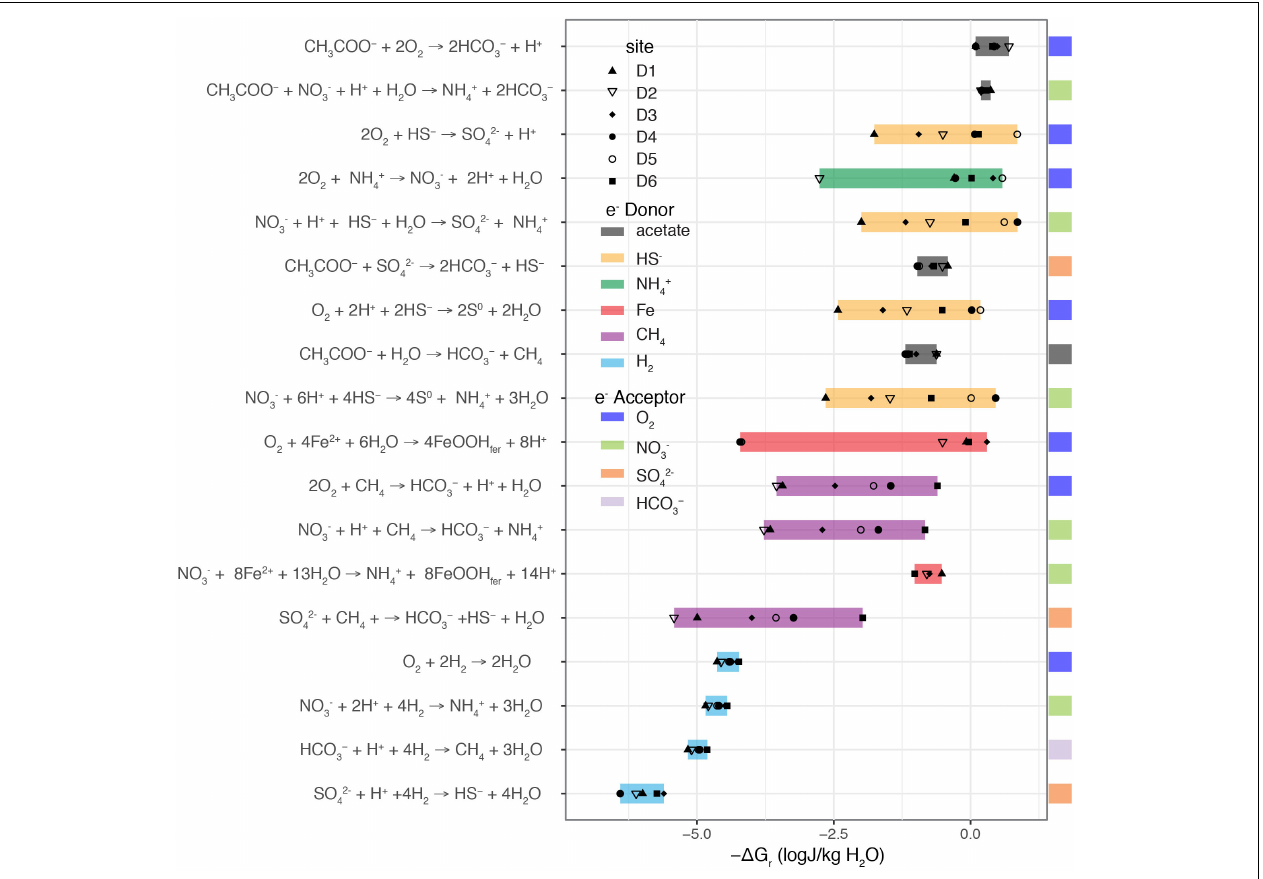
FIGURE 10 | Gibbs energy density of possible metabolic reactions for each DeMMO site. Full reactions are written on the left. Calculations for each site are indicated in by symbols where the full range observed for all sites is highlighted in a color bar corresponding to the e- donor. e- acceptor is indicated in the color bar on the far